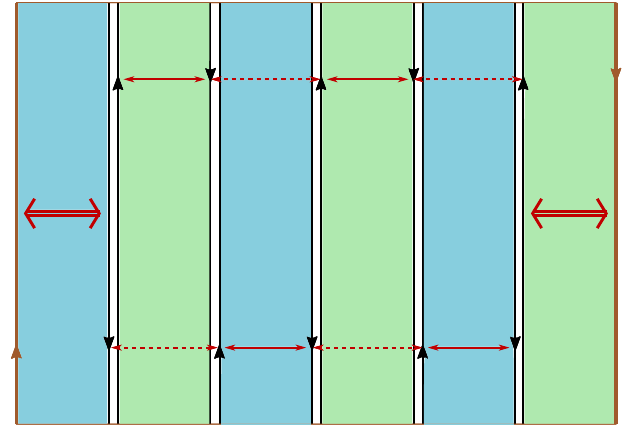
FIG. 8. Illustration of the gapped fermionic spectrum with Chern number C ¼ 0 or C ¼ 2 , depending on whether ˜ t (solid double lines) or t (dashed double lines) is